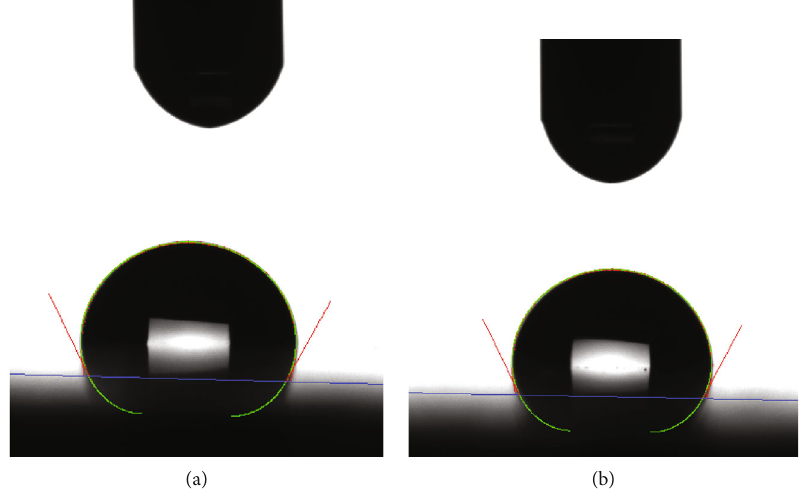
Figure 8: Contact angles of a water droplet placed on a thin fi lm of (a) NTEPA/Fe